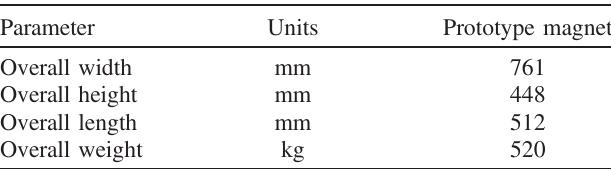
TABLE II. Overall prototype dimensions.